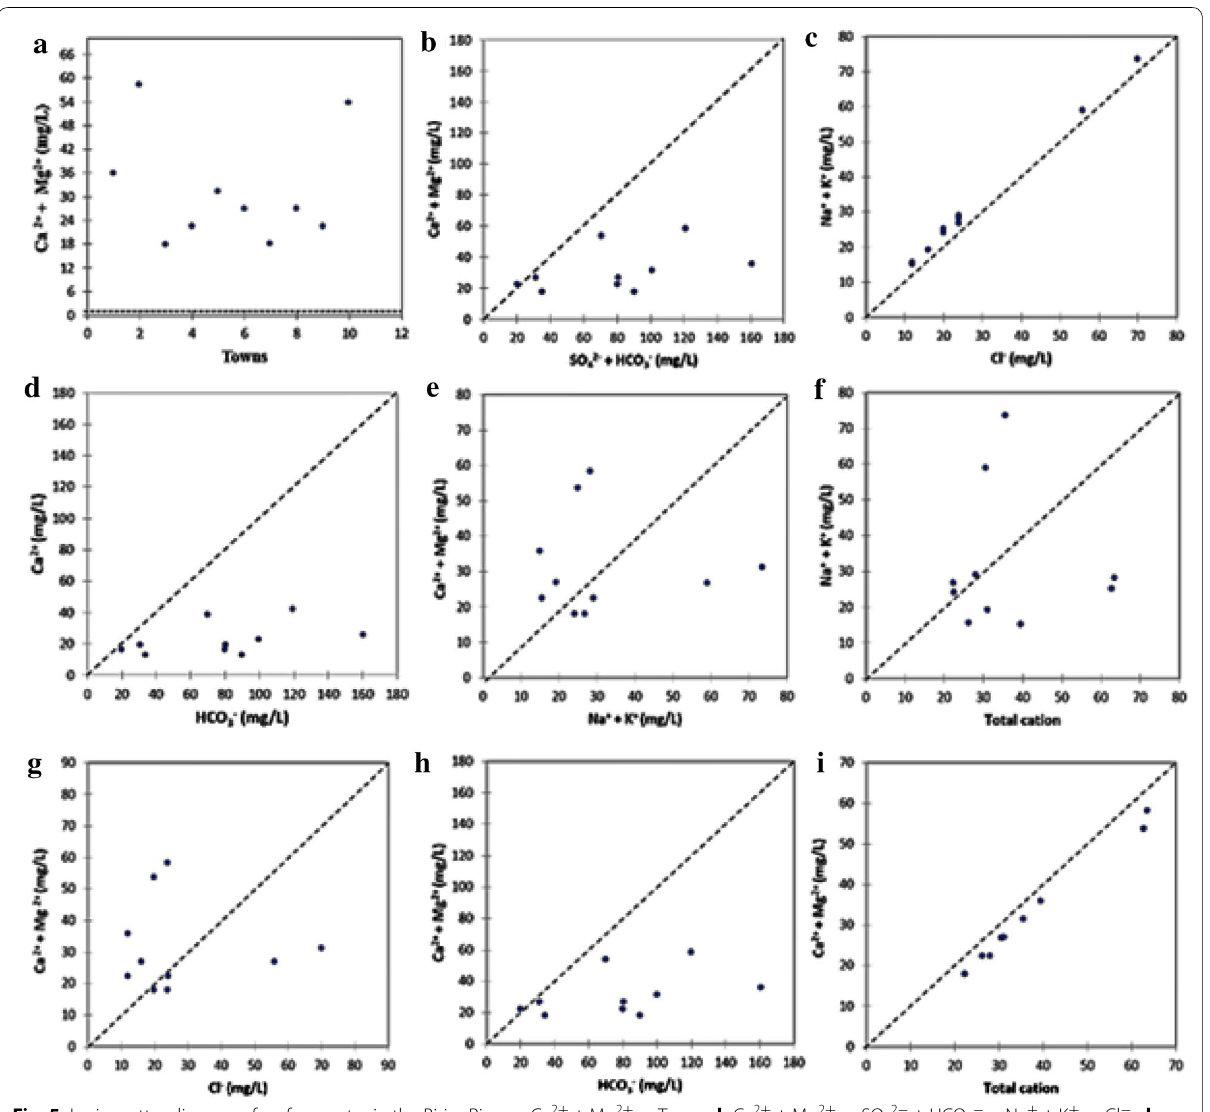
Fig. 5 Ionic scatter diagram of surface water in the Birim River: a Ca 2 + Ca 2 + vs HCO 3 − , e Ca 2 +